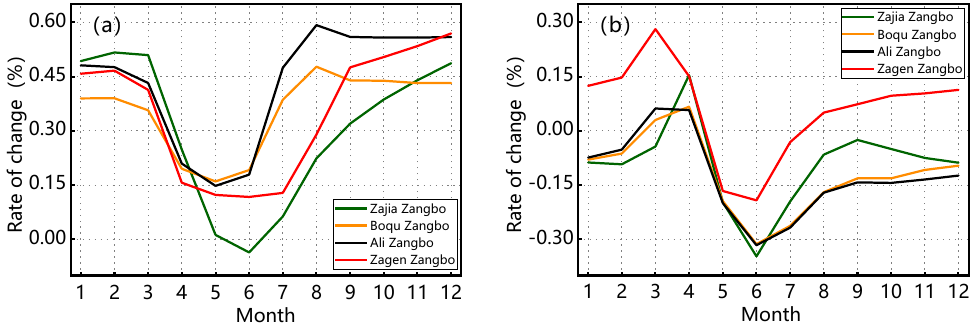
Figure 13. Variation in runoff caused by increased precipitation and temperature. ( a ) Precipitation increased by 10%; ( b ) temperature increased by 1 °C.